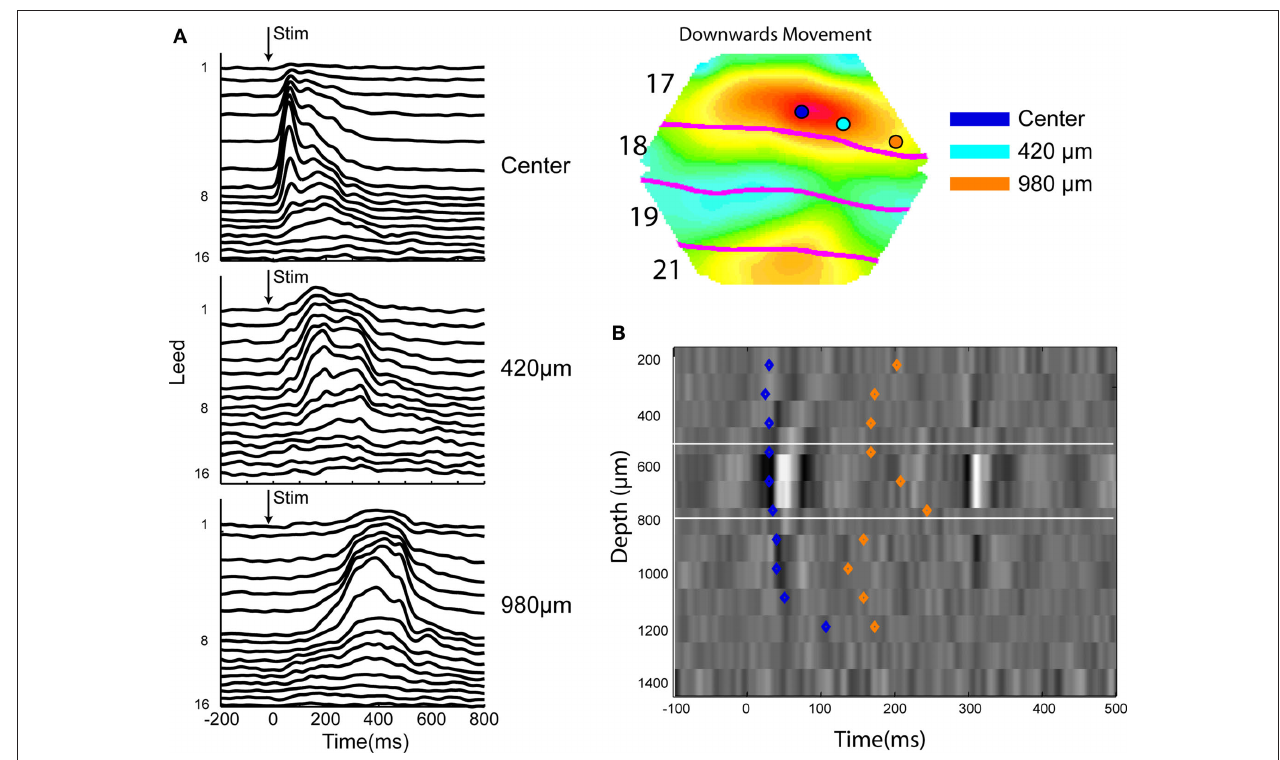
420 μm, i.e., 85 ms after the appearance the neurons in the upper layers fire first. At 980 μm, i.e., at 195 ms and after the FB the infra-granular neurons lead the onset of firing. (B) Current source density at the center cortical point with the onset latencies of the laminar onsets of firing (from M. Harvey, unpublished material from experiments described in Harvey et al.,